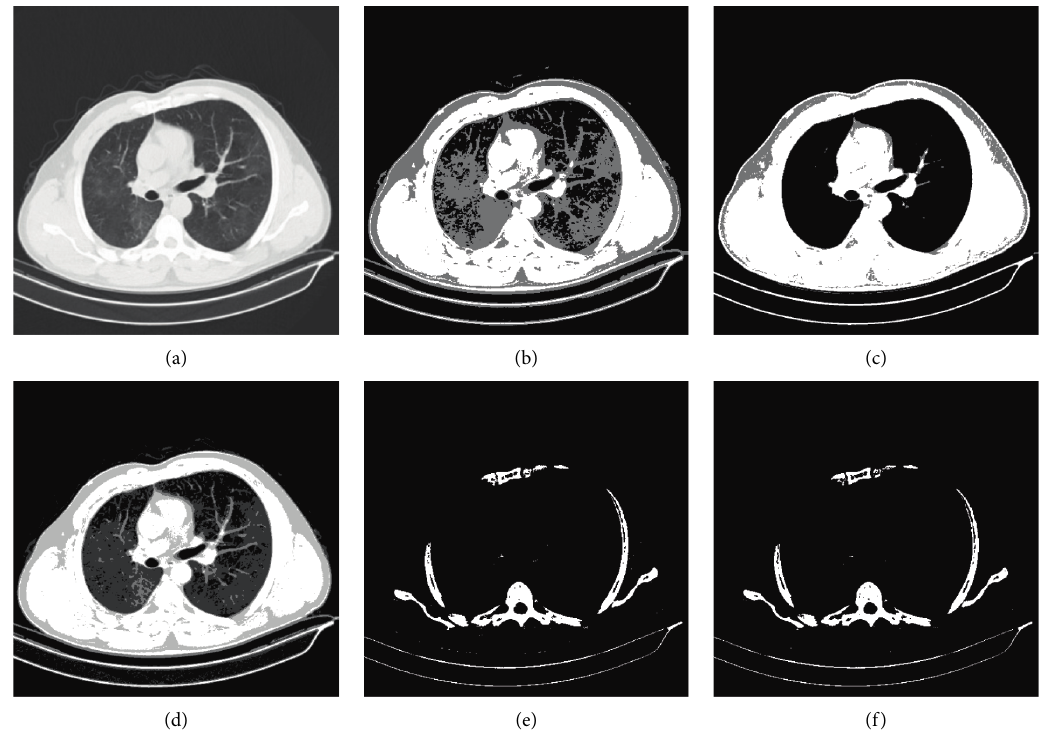
Figure 8: The comparison outcomes. (a) Original CT image-1; (b–d) segmentation result of threshold levels 2,3, and 4, respectively, of the proposed approach; (e) segmentation results obtained by Tao [21]; (f) segmentation results obtained by Tang [22].